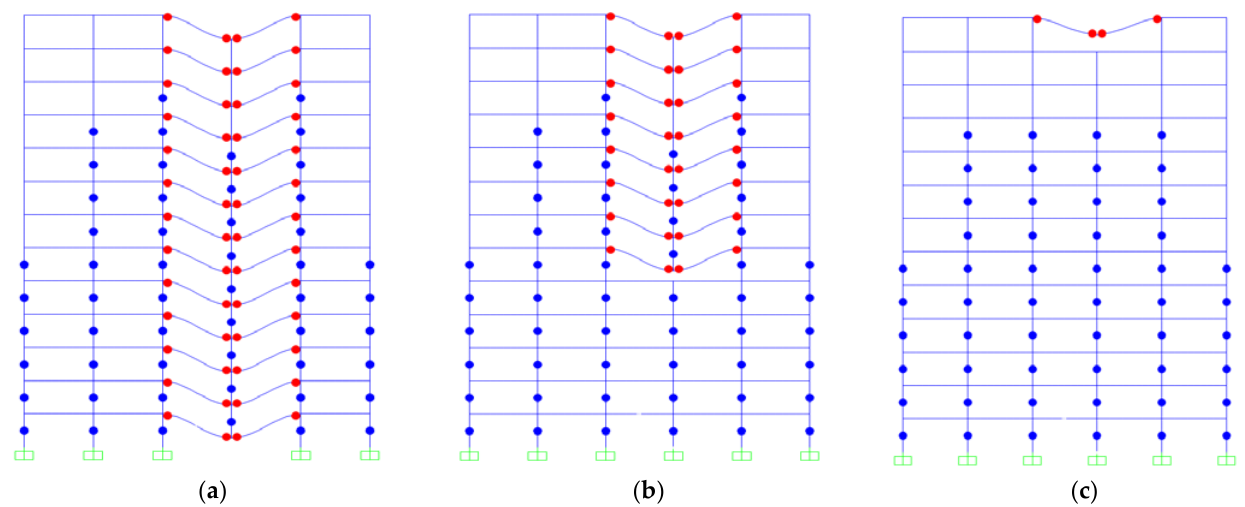
Figure 7. Hinge formation in the moment-resisting frame (Bare frame) exposed to column removal in ( a ) story one, ( b ) story six, and ( c ) story thirteen.